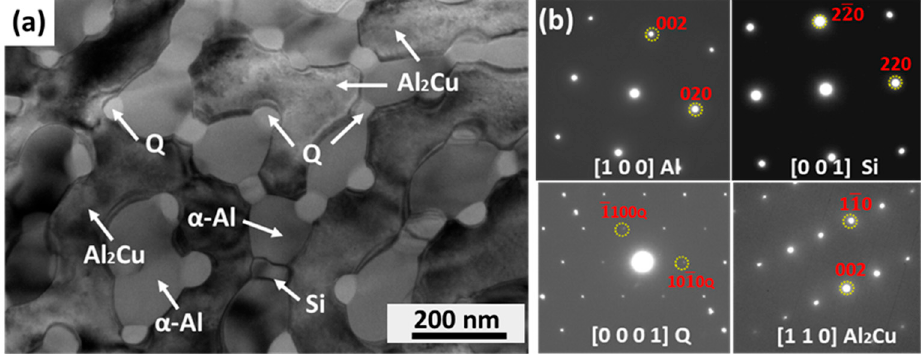
Figure 6. TEM bright-field image of ( a ) the microstructure taken from the cell centre and ( b ) corre- sponding SADPs of Al, Si, Q and Al 2 Cu phases.